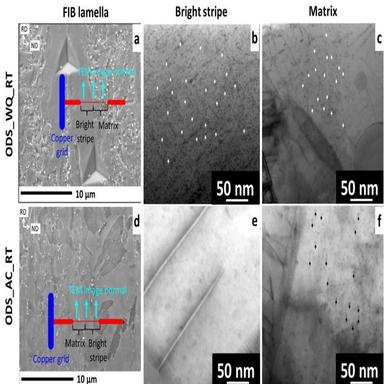
SEM micrographs showing FIB lamella taken out from etched a) ODS_WQ_RT (nanoindents are visible) and d) ODS_AC_RT including areas from a bright stripe and the adjoining matrix region. (b and e) represent a STEM bright field image from the bright stripe region and (c and f) represent a STEM bright field image from the matrix region for ODS_WQ_RT and ODS_AC_RT, respectively. White and black arrows are used to indicate some of the nano-particles in ODS_WQ_RT and ODS_AC_RT, respectively. The two alm